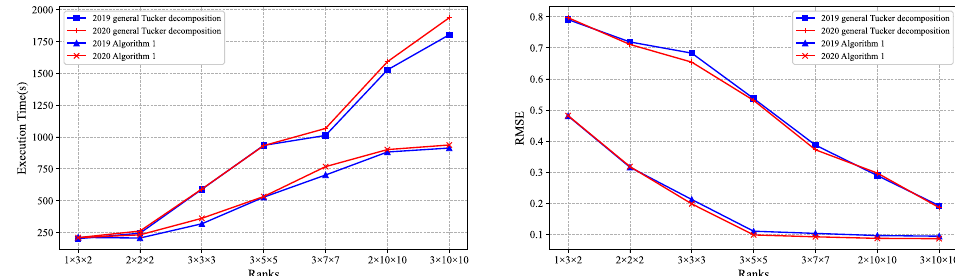
Figure 6. Execution time and the RMSE values with different rank sizes of core tensor.